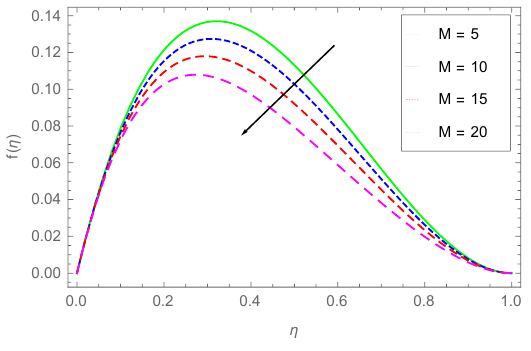
Figure 4. f ( η ) dependence on M . The variation of the fluid velocity f ( η ) with enhancing Grashof number ( Gr n ) is depicted in Figure 5. It is observed that for a given value of Gr n , the fluid velocity first enhances, reaches the maximum, and then, drops to smaller values with the increasing η . The velocity profile rises with the augmenting Gr n . The increase in the velocity profile is more prominent at the intermediate values of η as is clear from the wider